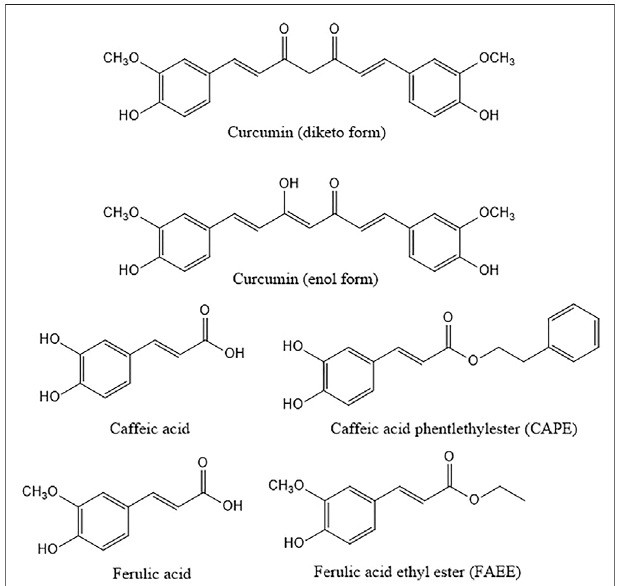
FIGURE 1 | Structures of curcumin and the related compounds caffeic, ferulic acid and their ethyl and phenylethyl esters. Curcumin is here represented in both diketo and enol form the latter being the main form present in